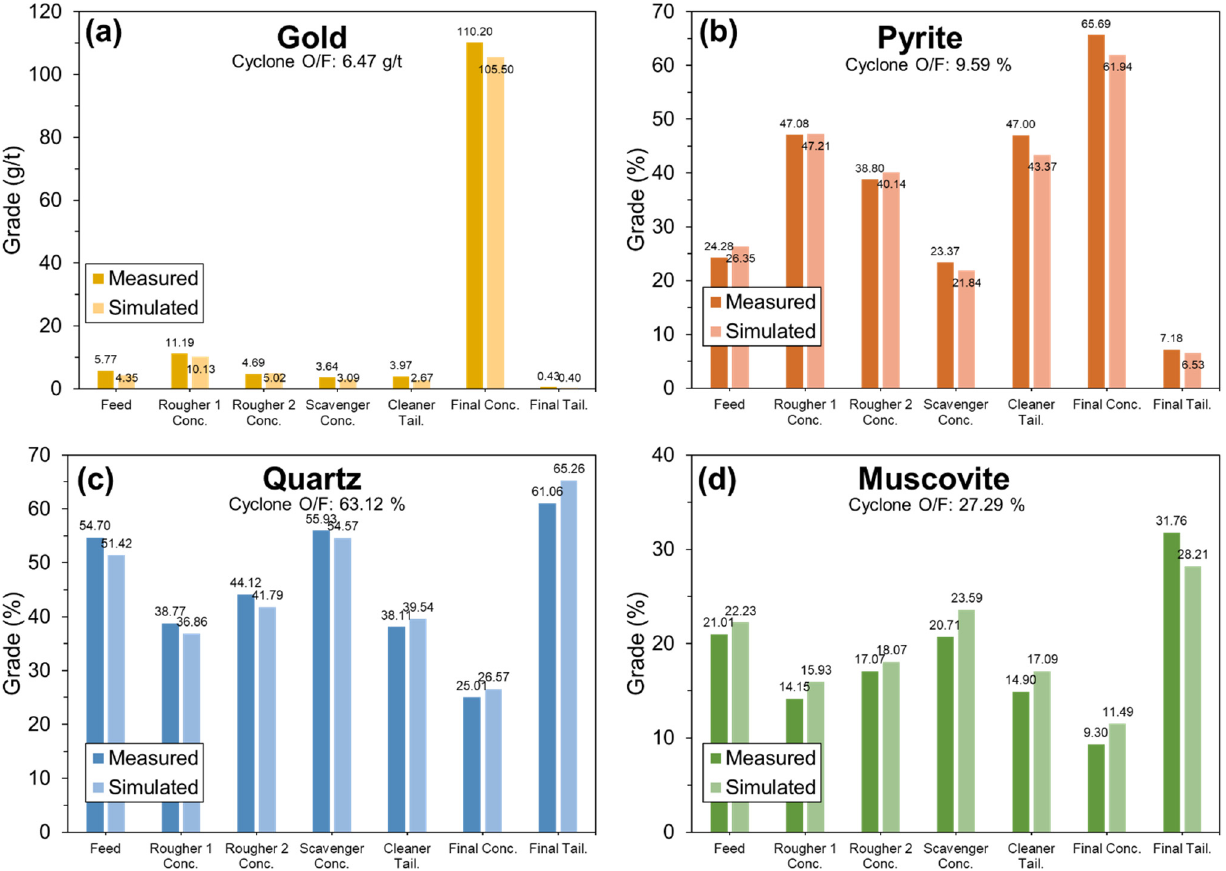
Figure 7. Comparison between experimental and simulated grade distributions of each stream in industrial plant: ( a ) Gold, ( b ) pyrite, ( c ) quartz, and ( d ) muscovite.